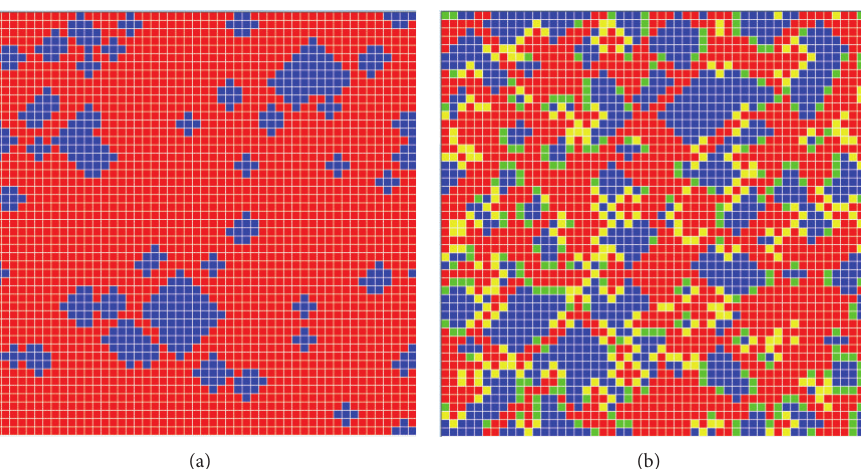
Figure 4: Simulation results on a 50 × 50 square lattice with von Neumann neighborhood and random initial distribution of players. The pattern in (a) is performed by the parameters region: 𝑢 1 0 > 𝑢 2 1 , 𝑢 2 0 < 𝑢 3 1 , 𝑢 3 0 < 𝑢 4 1 , and the pattern in (b) is by the region: 𝑢 1 0 < 𝑢 2 1 , 𝑢 2 0 < 𝑢 3 1 , > 𝑢 4 𝑢 3 0 1 .